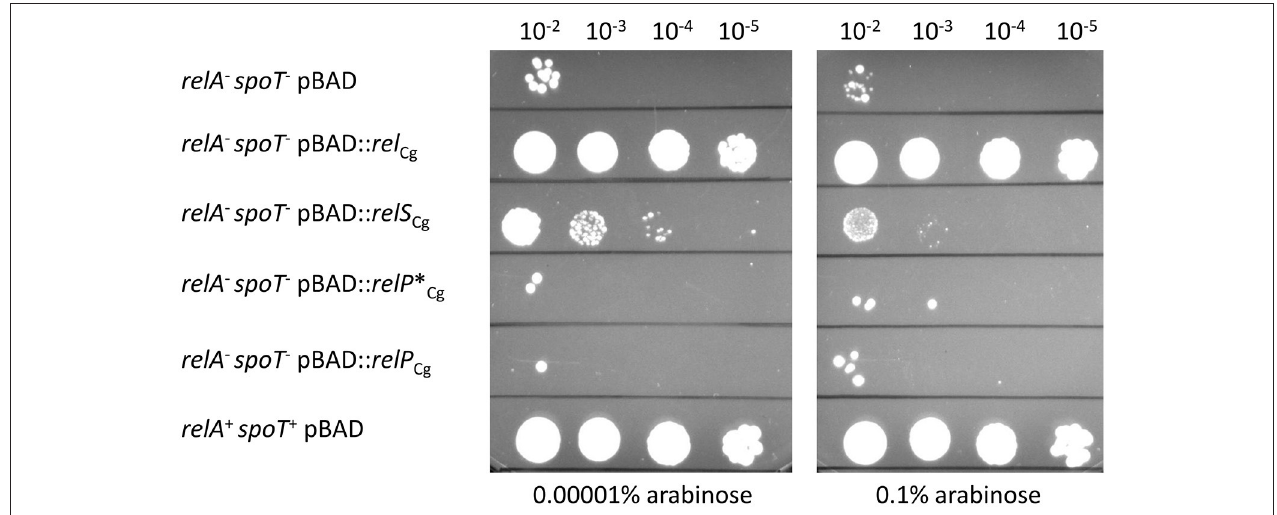
FIGURE 3 | Growth complementation of E. coli 1 relA 1 spoT on minimal medium plates by heterologous expression of C. glutamicum genes rel Cg , relS Cg , relP * Cg, or relP Cg . The parental strain E. coli MG1655 and E. coli 1 relA 1 spoT each containing the empty vector pBAD24 were used as a positive and negative control, respectively. All strains were cultivated using initial OD 600 values of 0.05 in LB-Medium containing 0.001% arabinose for 3 h. The cells were washed and serially diluted in PBS-buffer. 5 µ L aliquots of every strain and dilution stage were spotted on minimal medium plates with 0.4% glycerol as carbon source and different arabinose concentrations. Incubation was carried out at 37 ◦ C for 48